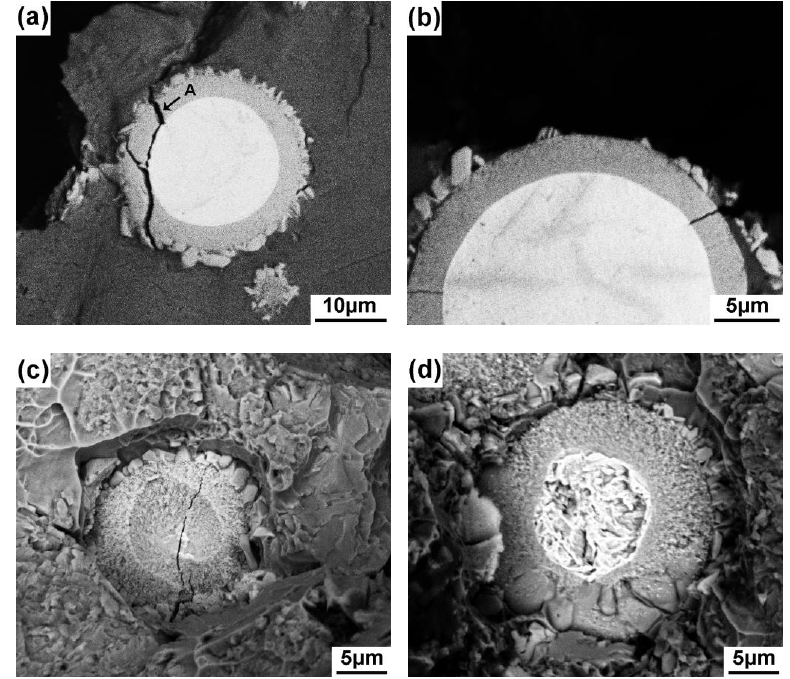
Figure 15. SEM micrographs of the failed reinforcements.